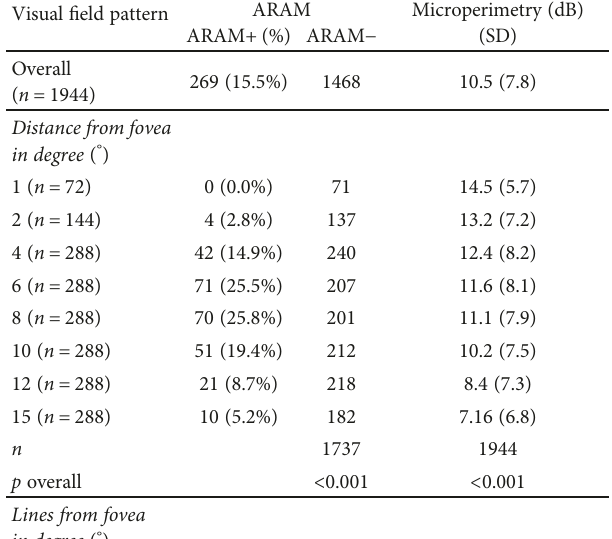
Table 1: Descriptive and demographic data of the cohort. Patients ( n = 12 )